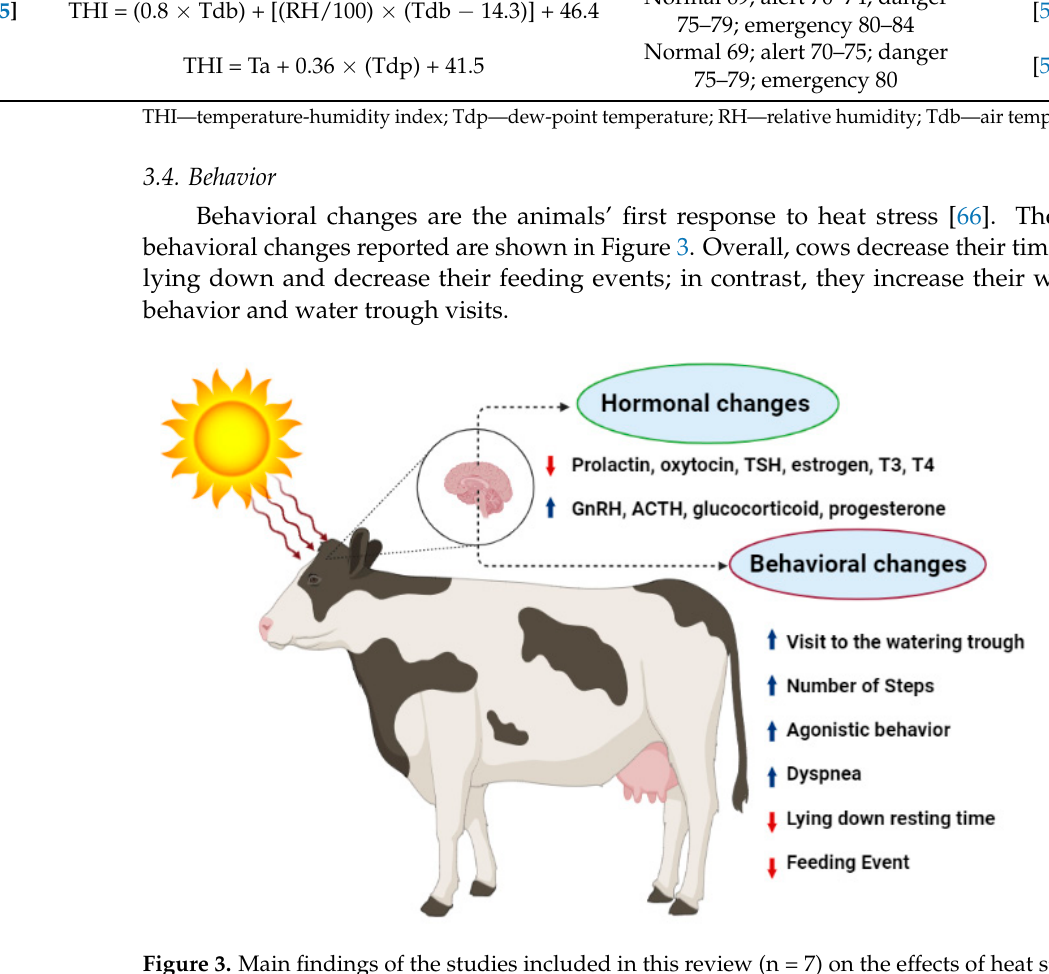
Figure 3. Main findings of the studies included in this review (n = 7) on the effects of heat stress on the behavior of lactating cows raised in compost the behavior of lactating cows raised in compost barns.